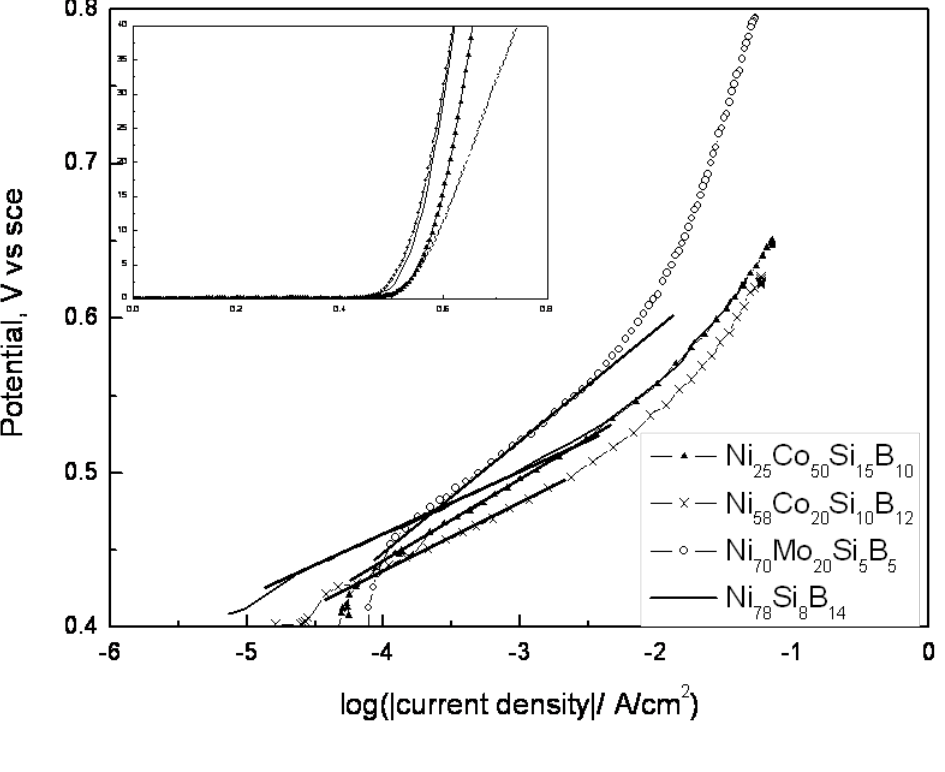
Figure 5. Tafel curves for Ni containing metallic glasses in 1 M KOH at 25 ○ C in the N atmosphere. The inserted CV-Figure reveals that the Tafel slopes at high potentials change with the